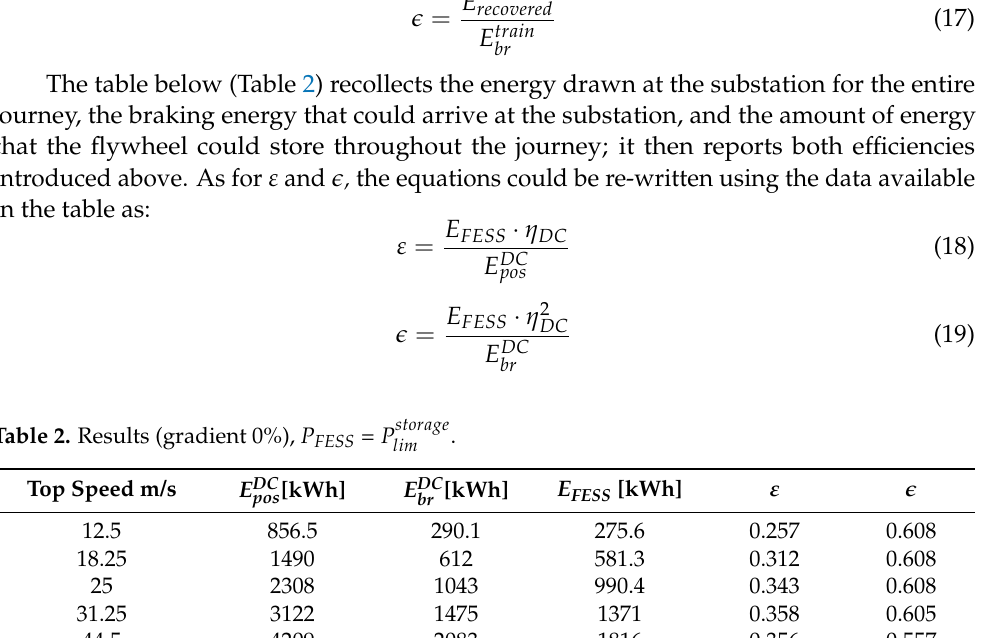
Table 2. Results (gradient 0%), P FESS = P storage